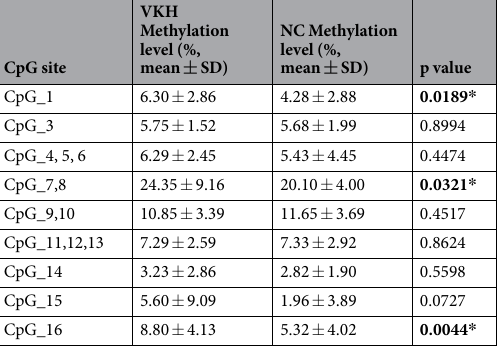
Table 1. Methylation levels of IRF8 promoter in DCs from VKH patients versus normal controls. VKH patients (n = 20, M:F = 14:6); Age (years: mean ± SD): 38.85 ± 11.47. Normal control (n = 30, M:F = 21:9); Age (years: mean ± SD): 38.99 ± 11.04.